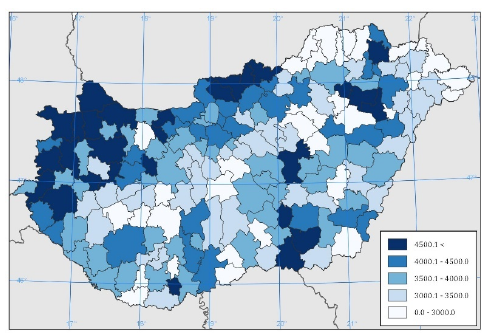
Figure 7: Total number of confirmed COVID-19 cases per 100,000 inhabitants at the micro-regional level of Hungary (LAU 1) between 4 March 2020 and 14 February 2021